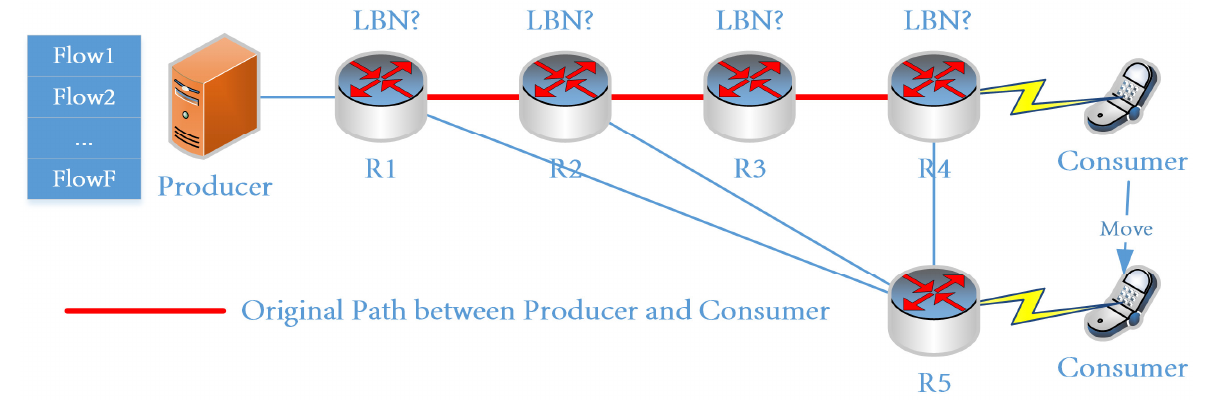
Figure 2. Late-binding node selection problem model.